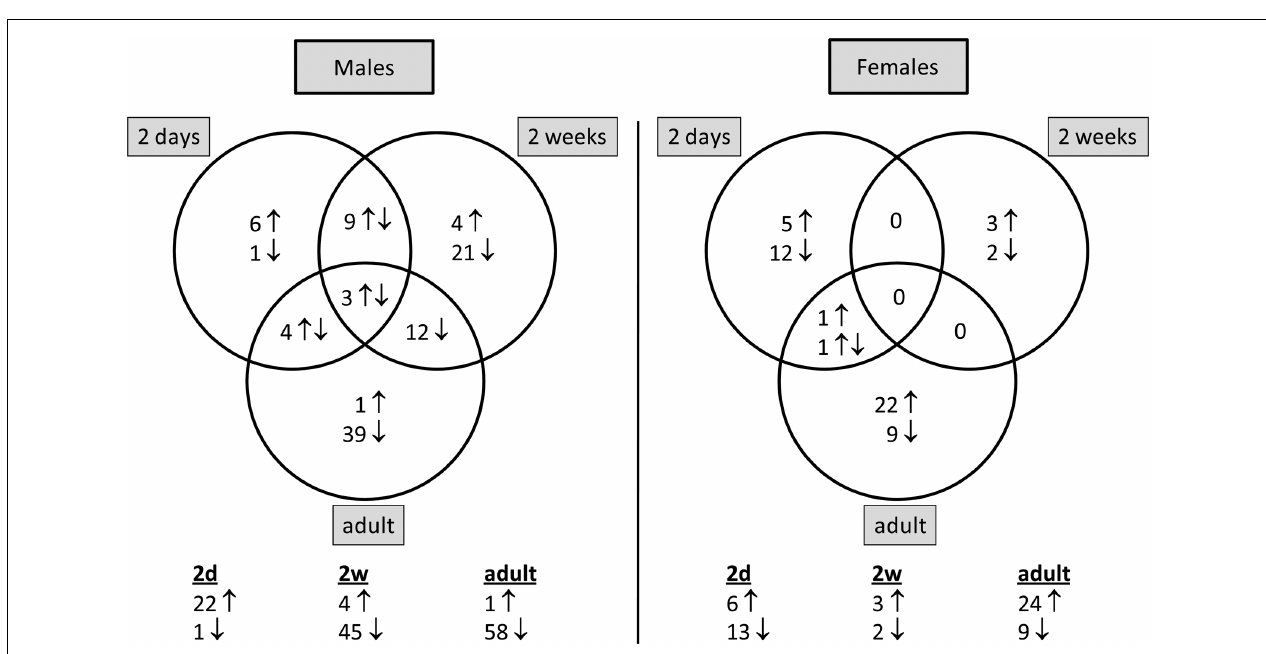
the diagram is noted the total number of ribosomal protein genes that are significantly differentially expressed in molsidomine vs. control FHH rats at each